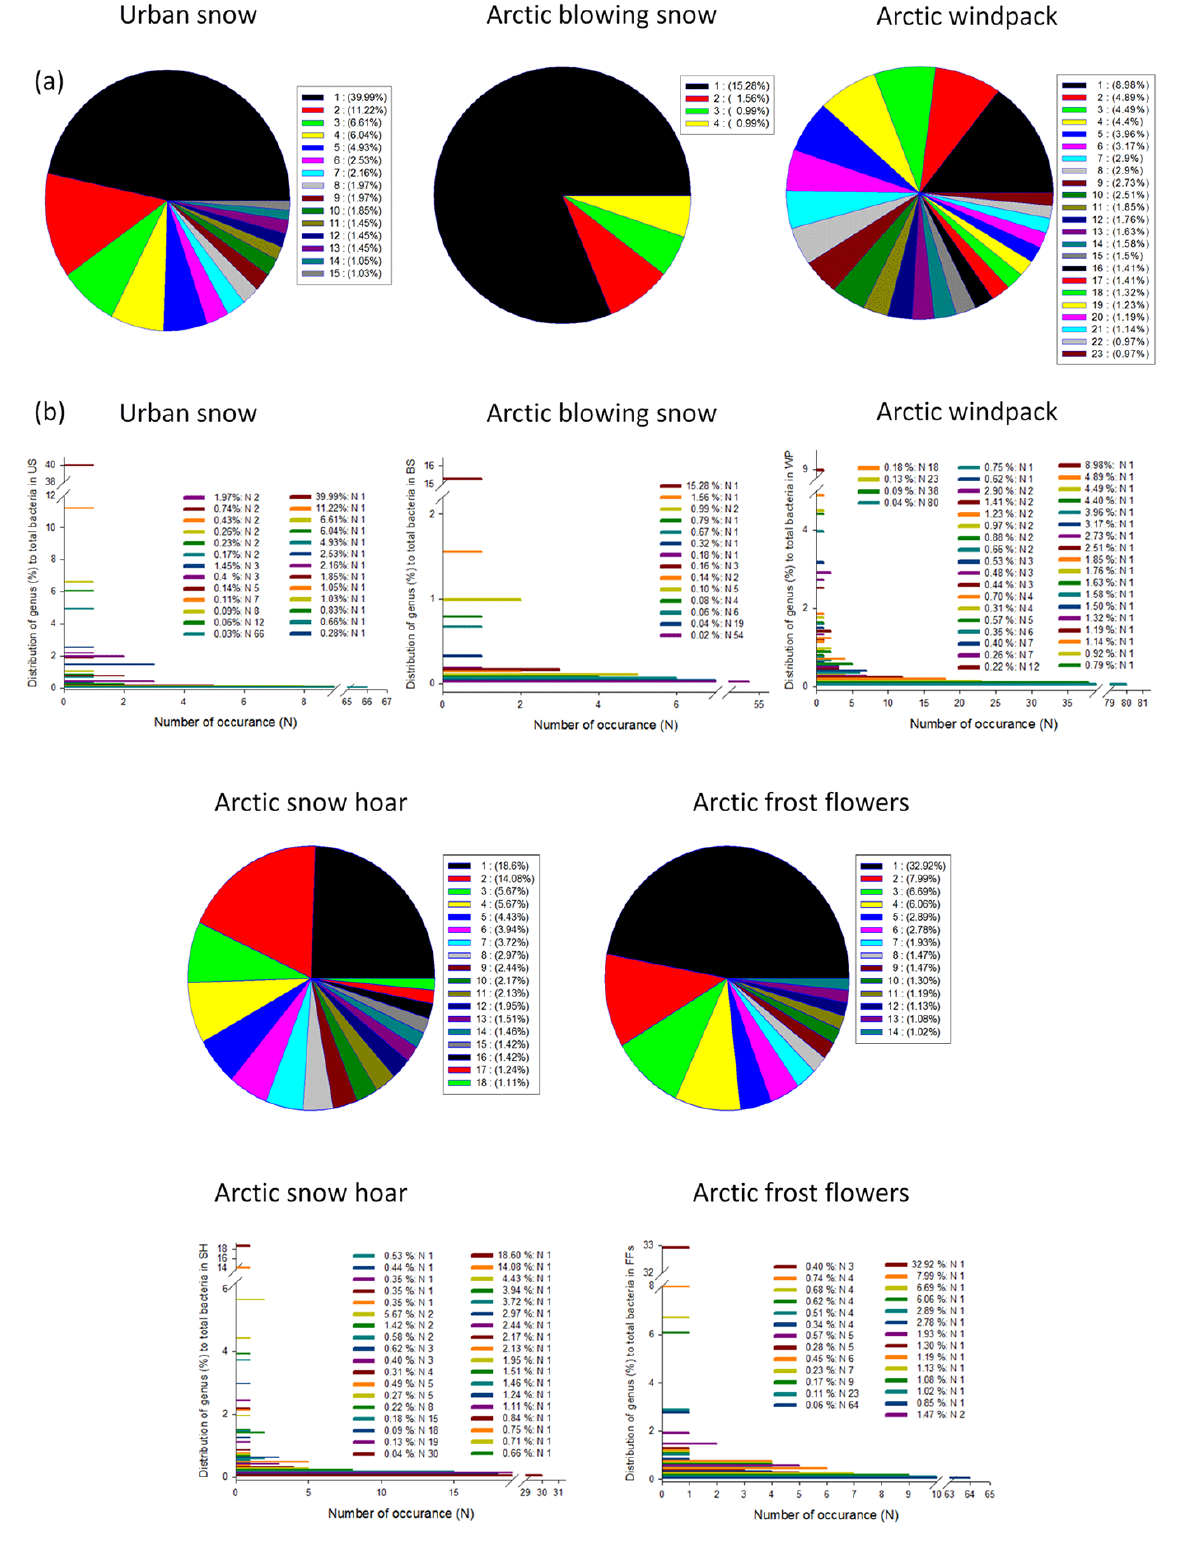
Figure 2. Bacterial community composition in Arctic samples and urban snow at genera level as detected by Roche 454 GS-FLX Titanium. (a) : distribution of bacterial genus observed at greater than 1%. (b) : number of occurrence for each percentage observed for any genus in total bacteria. (The name of corresponding genera for each percentage (>1%) is listed in the Appendix Table A2).